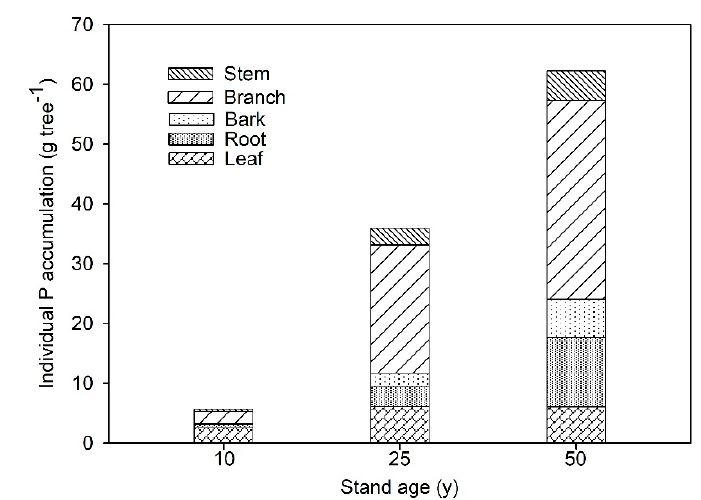
Figure 1. Individual P accumulation of each tree component for different stand ages in larch plantations.